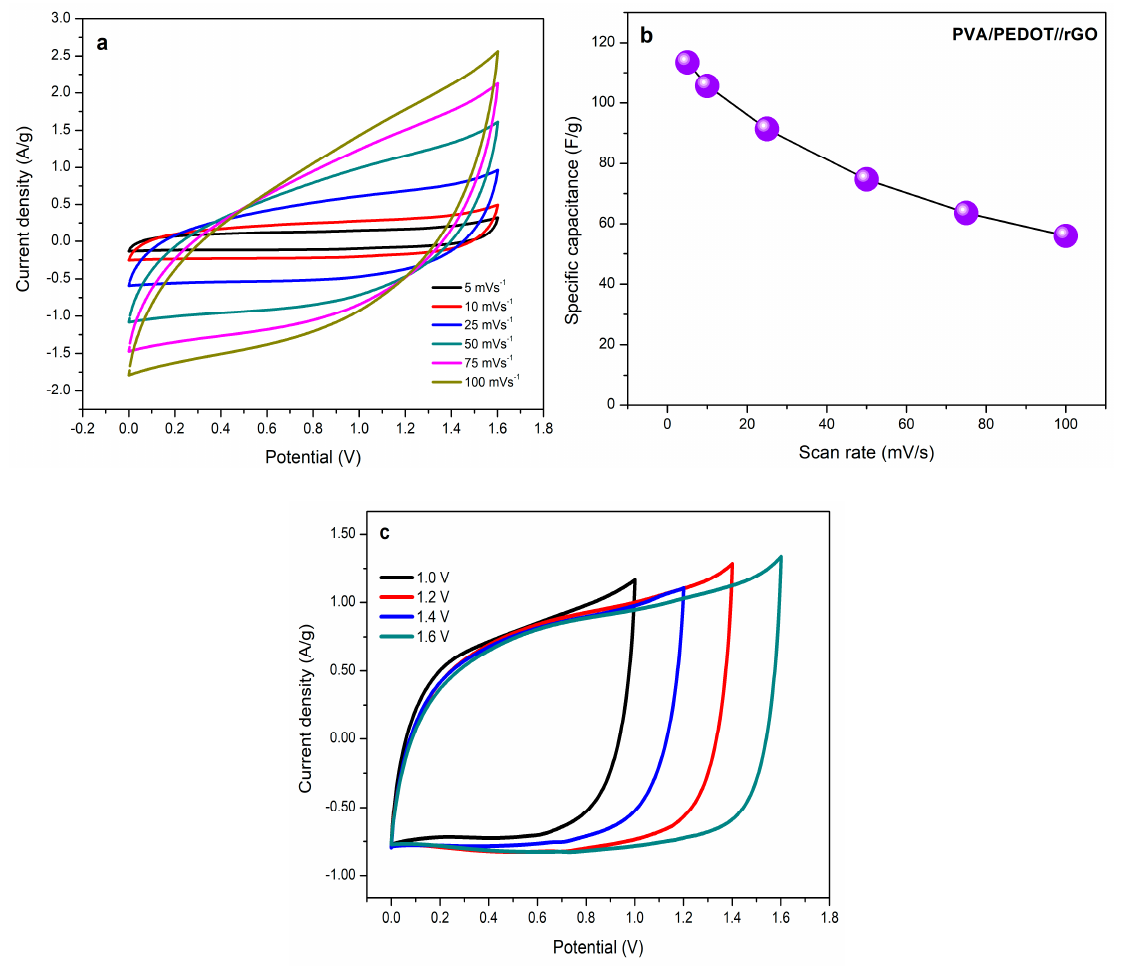
Figure 5. ( a ) CV curves of PVA/PEDOT nanofibers//rGO asymmetric cell at various sweeping rates ranging from 5 to 100 mV·s − 1 , ( b ) specific capacitance of PVA/PEDOT nanofibers//rGO cells at different sweeping rates, ( c ) CV profiles at potential windows from 1.0–1.6 V at sweeping rate of 25 mV·s − 1 .